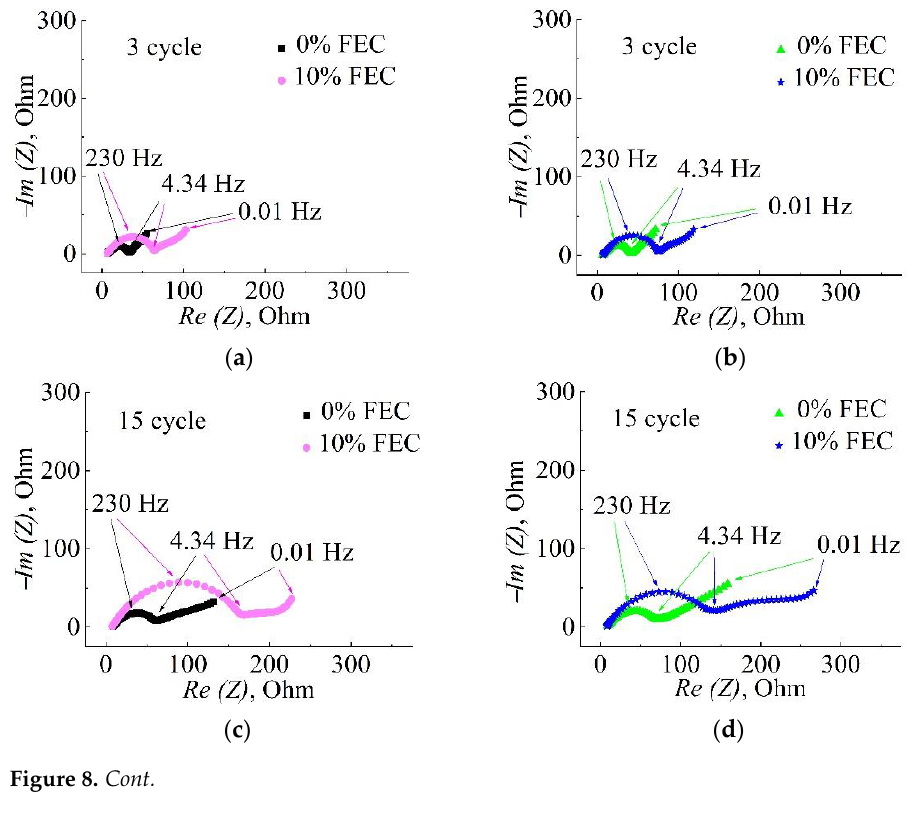
( B ) Figure 8. Transformation of the Nyquist plot shape in the process of cycling. Spectra for 3, 15, 30, 150 and 300th cycles are shown: left column for pair ( A ) ( a , c , e , g , i ); right column for pair ( B ) ( b , d , f , h , j ). Based on the spectra obtained, the following equivalent electrical circuit consisting of 5 series-connected elements was proposed (Figure 9).